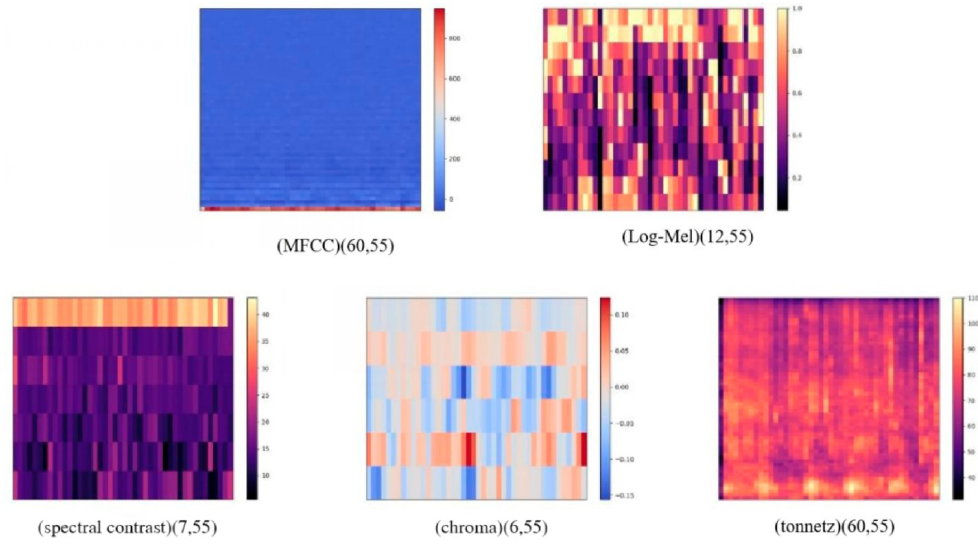
Fig 7. Schematic diagram of the features of the five types of samples.